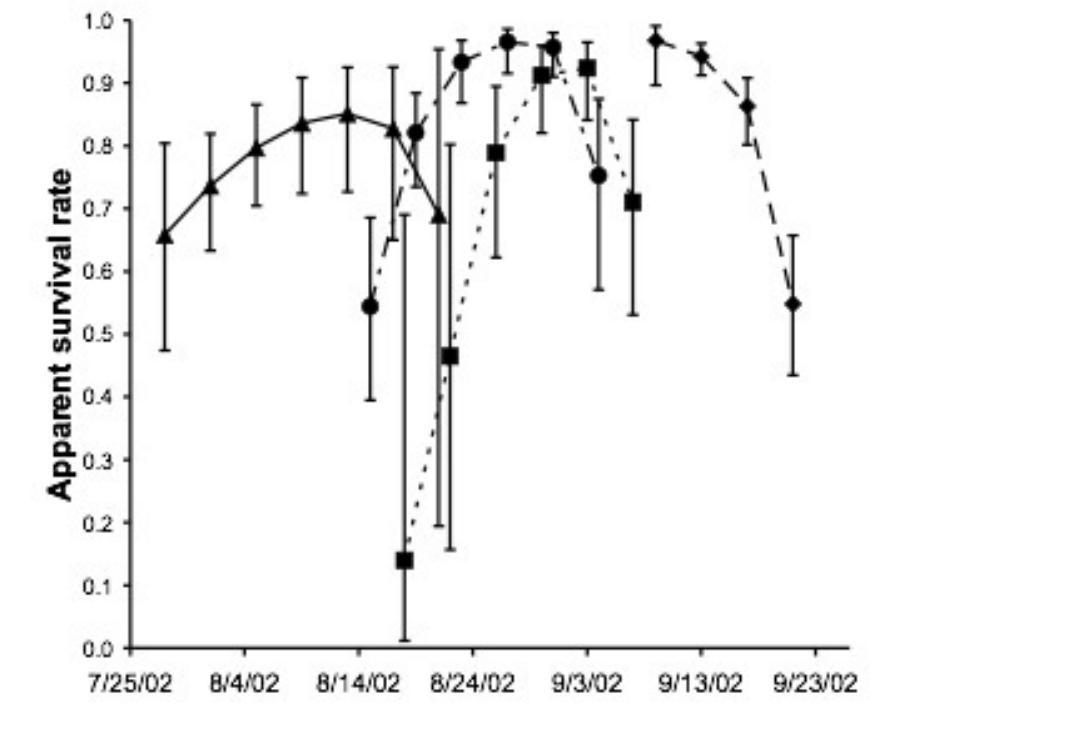
Fig. 2. Estimated apparent survival rate and 95% confidence intervals for Least Sandpipers at study sites in the Lower Mississippi River Alluvial Valley during fall migration 2002 derived from the model f TT4*group p site. Triangles represent birds at Bald Knob National Wildlife Refuge, Arkansas, squares represent adult birds and circles represent juvenile birds at Yazoo National Wildlife Refuge, Mississippi, and diamonds represent birds at Morgan Brake National Wildlife Refuge,